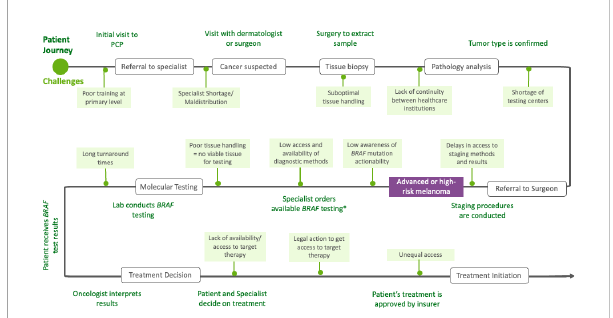
FIGURE 2 Patient journey of people with BRAF melanoma in Latin America. PCP, primary care